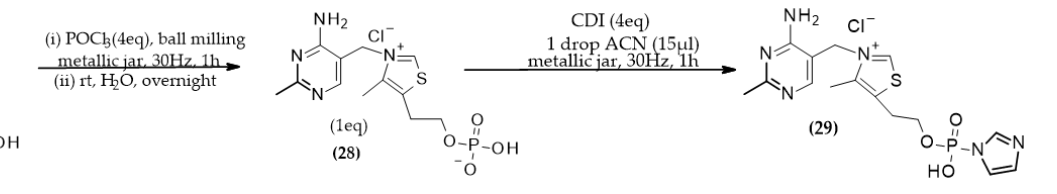
Scheme 2. Synthesis of thiamine monophosphate and its imidazolate. Table 1. Phosphorylation conditions, reaction time, conversions, and isolated yields.